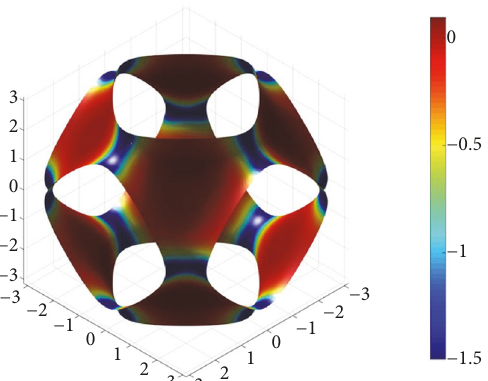
Figure 9: Color map of G distribution for a P-surface with k = -0.7 and s =